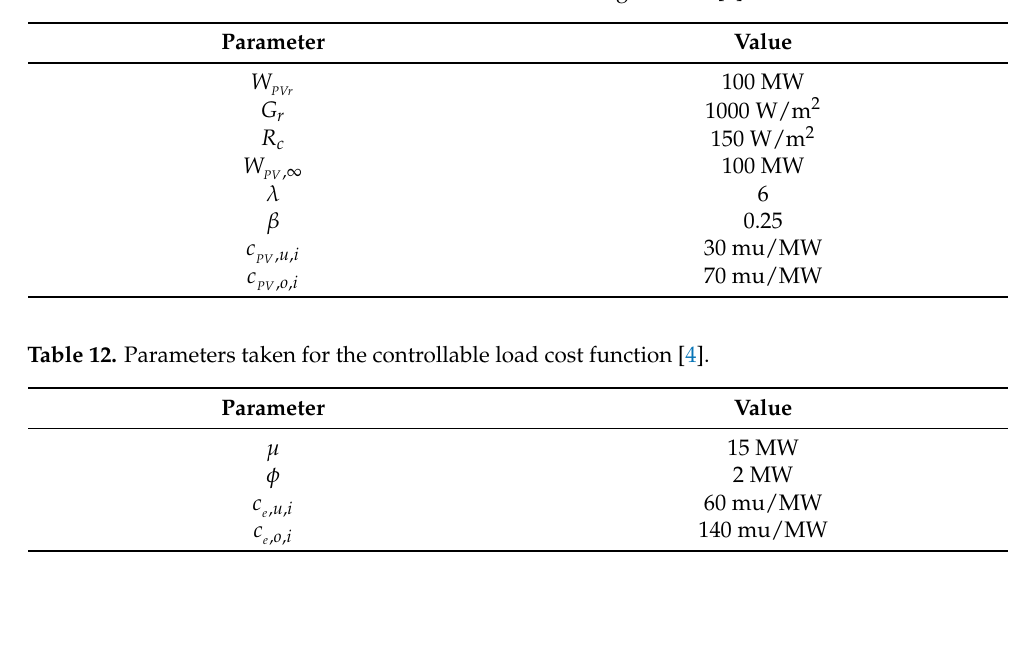
Table 11. Parameterstaken for the cost function of the solar generator [4].